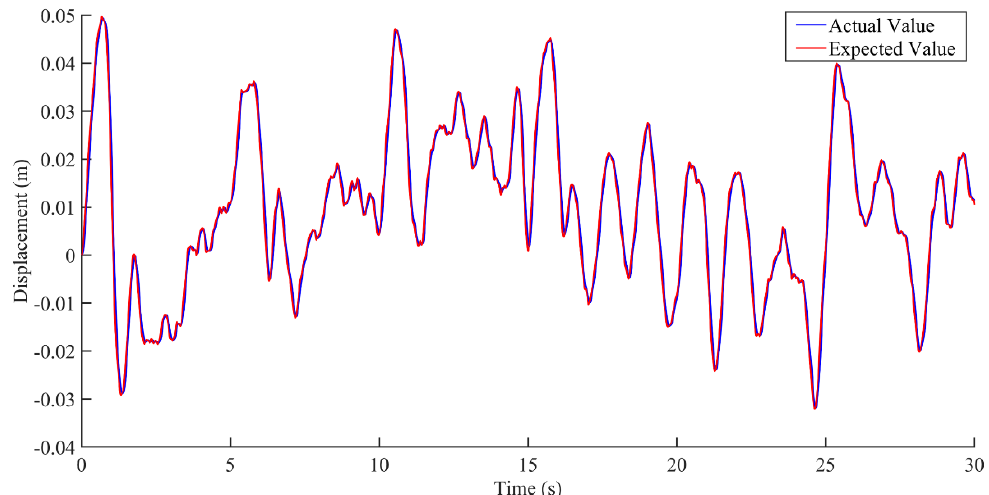
Figure 16. Comparison between the actual value and the expected value of vibration displacement based on the integral sliding mode control under the condition of interference.